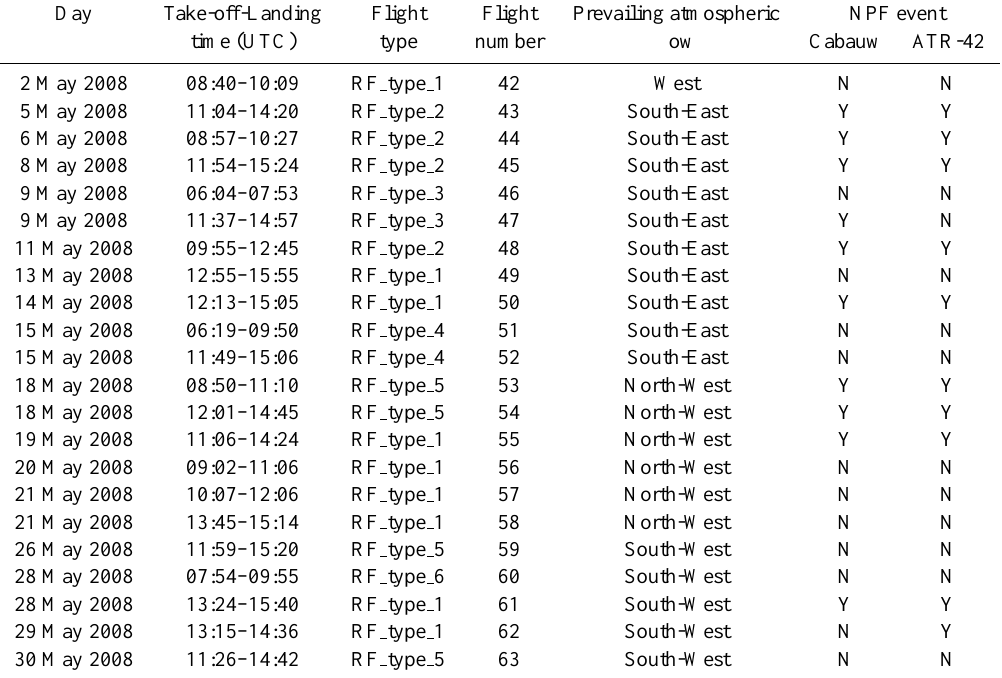
Table 1. Overview of ATR-42 flights performed during the EUCAARI campaign: day, times, Flight number and plans of all flights. The prevailing atmospheric flows at low level (850hPa) and observation flag of new particle formation (NPF) event at Cabauw (from SMPS and NAIS measurements) and on-board the ATR-42 (from SMPS measurements) are